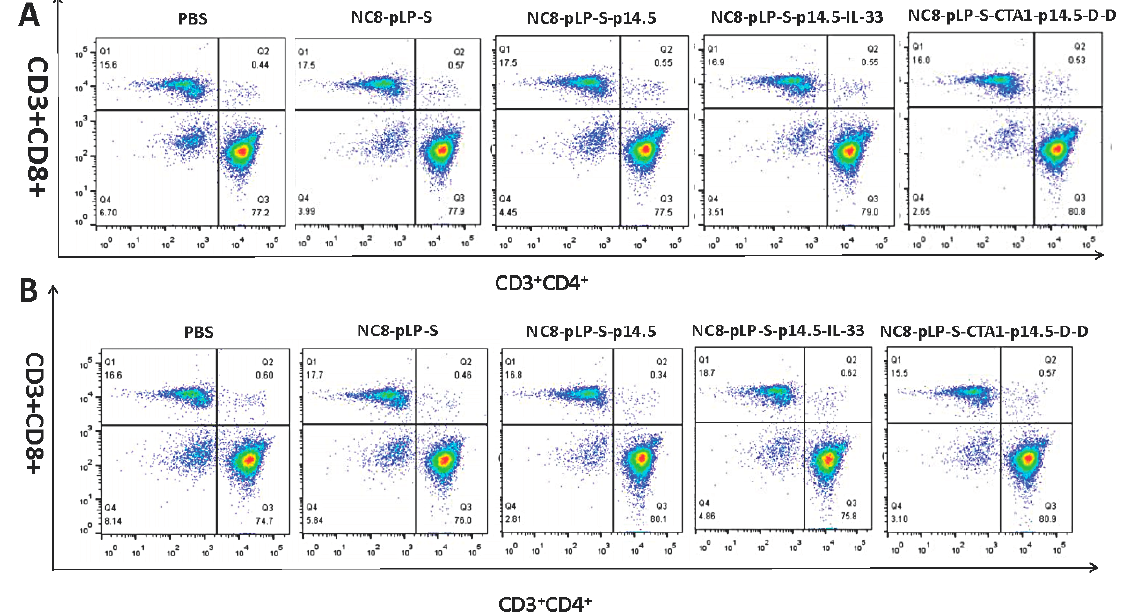
Figure 2. Flow cytometry to detect the degree of T cell differentiation. ( A ) Changes in the numbers of CD3 + CD4 + and CD3 + CD8 + T cells in the spleen; ( B ) Changes in the numbers of CD3 + CD4 + and CD3 + CD8 + T cells in the mesenteric lymph nodes. The degree of T cell differentiation in descending order is the CTA1-DD adjuvant group, IL-33 adjuvant group, single antigen group, empty vector group and control group.